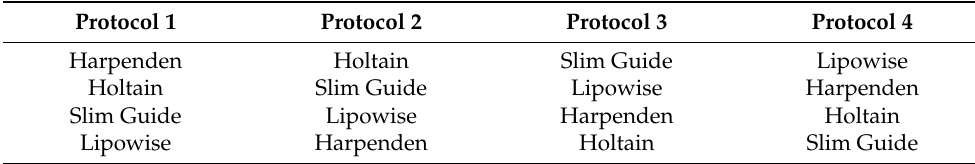
Table 1. Skinfold measurement